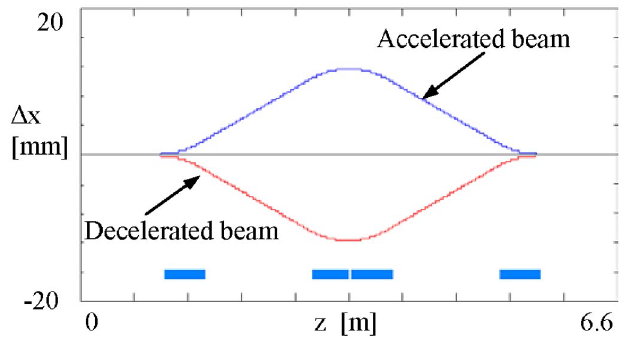
FIG. 10. (Color) Horizontal displacement of both beams in the bypass chicane (four identical dipole magnets—marked as blue bars).